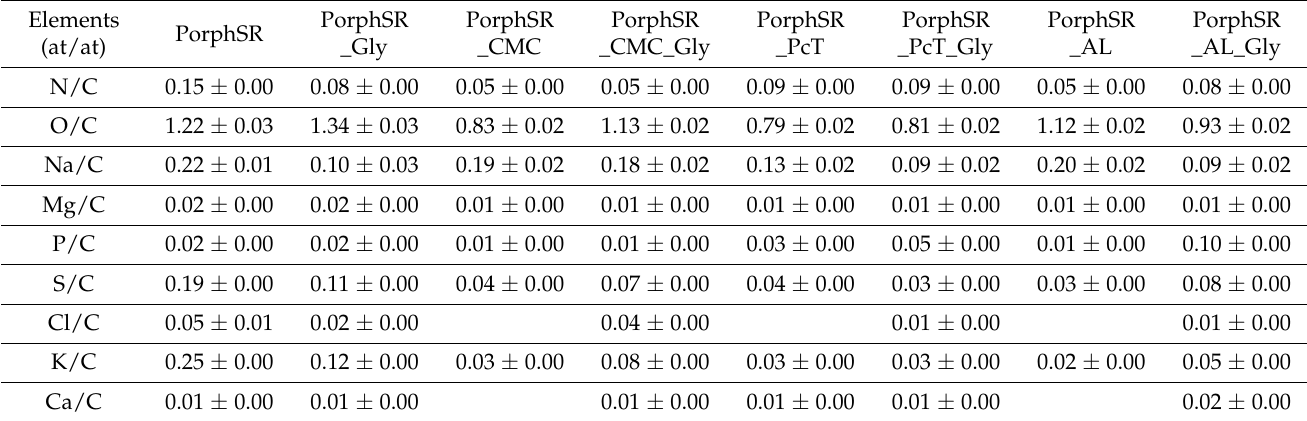
Table 3. Element/carbon ratio on the produced films, obtained by semiquantitative microanalysis (hydrogen atomic number is below the EDS equipment detection ability, preventing its quantification).